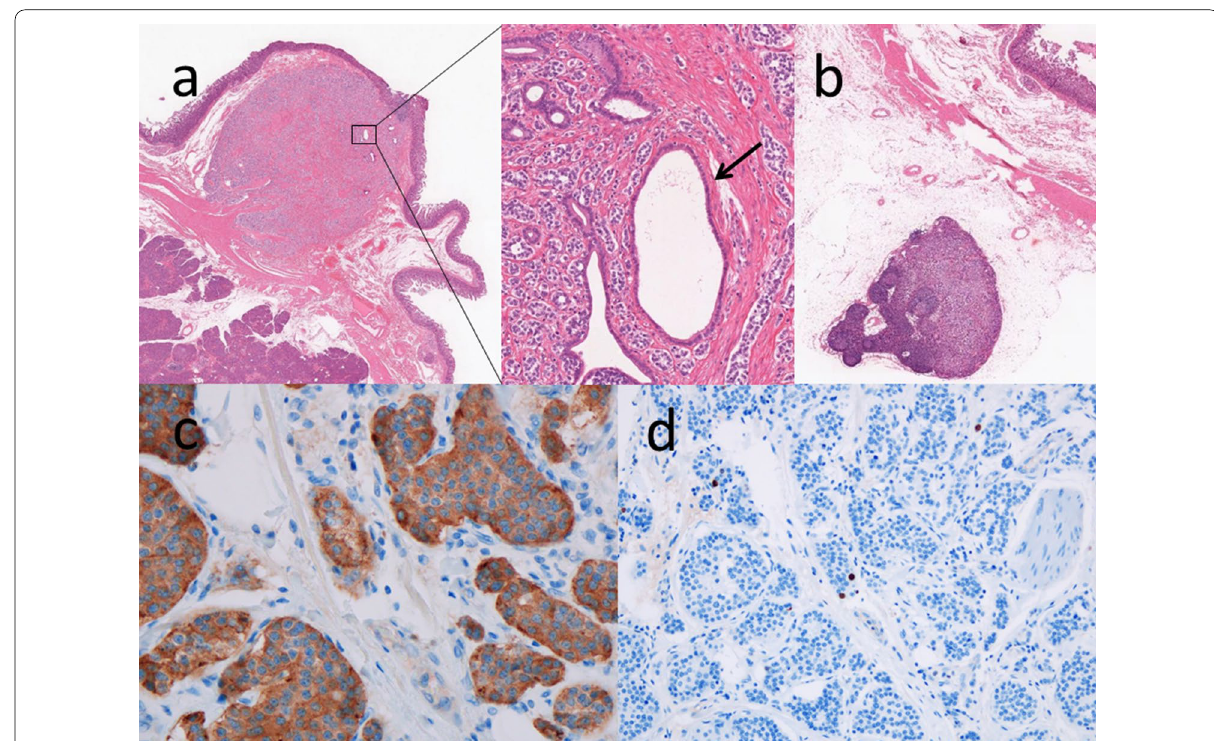
Fig. 2 The tumor at the accessory papilla as the accessory pancreatic duct (arrow) is shown. Hematoxylin and eosin stain demonstrating nesting pattern of mostly uniform cells with central ovoid nucleus ( a ). The lymph node metastasis ( b ). Synaptophysin showing positive ( c ). Ki-67 index stain showing < 1% proliferation ( d